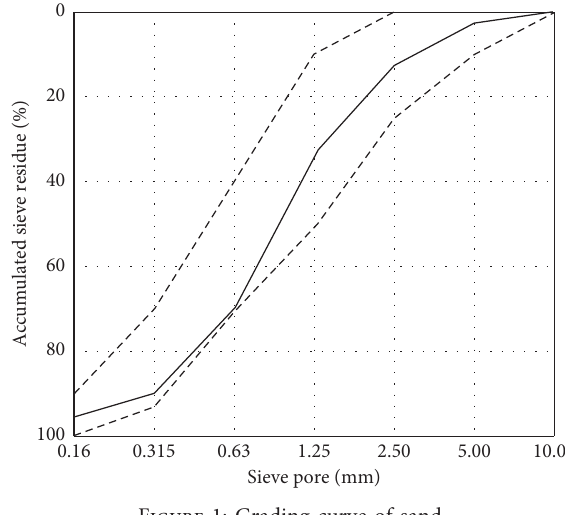
Figure 1: Grading curve of sand.